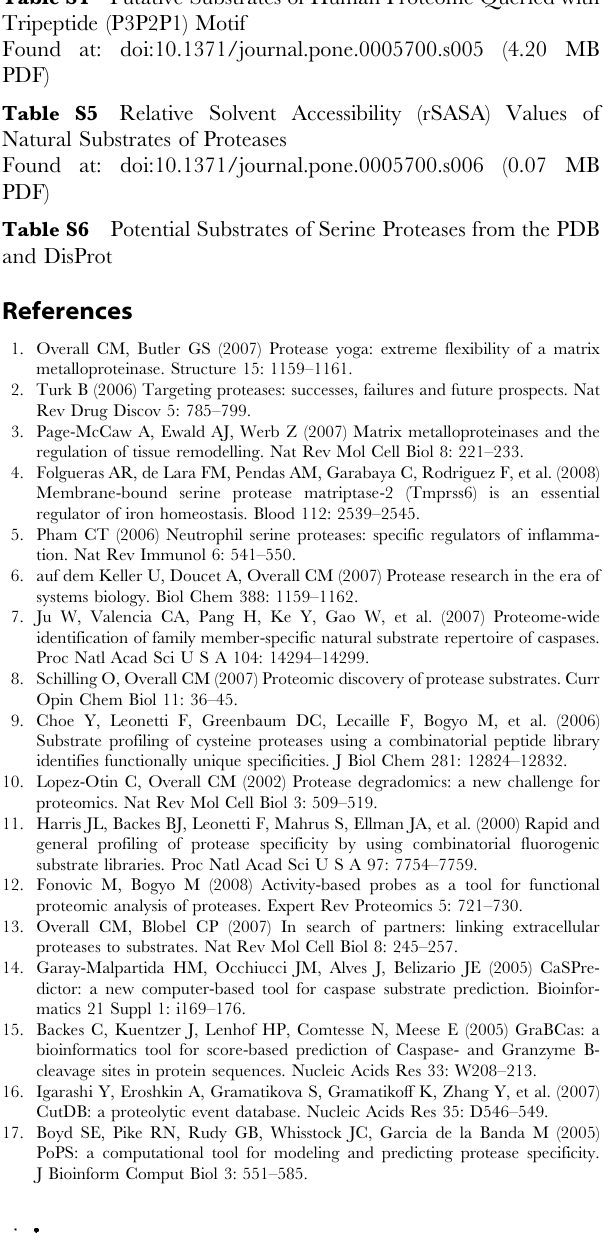
Table S3 Putative Substrates of Aspartate,Cysteine and Serine catalytic type of proteases obtained by matches with Human